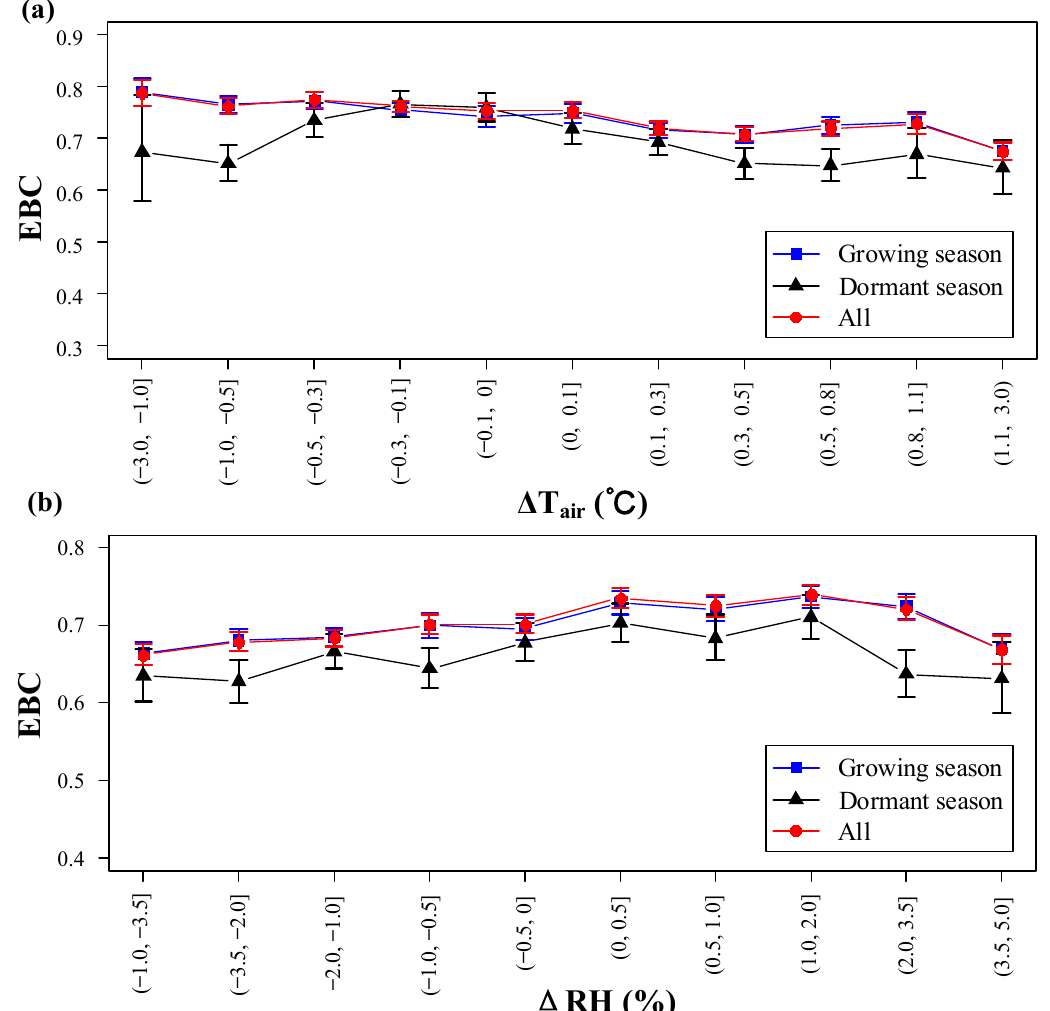
Figure 15. Average EBC for each bin of ( a ) 30-min air temperature difference (ΔT air ), and ( b ) 30-min relative humidity difference (ΔRH).